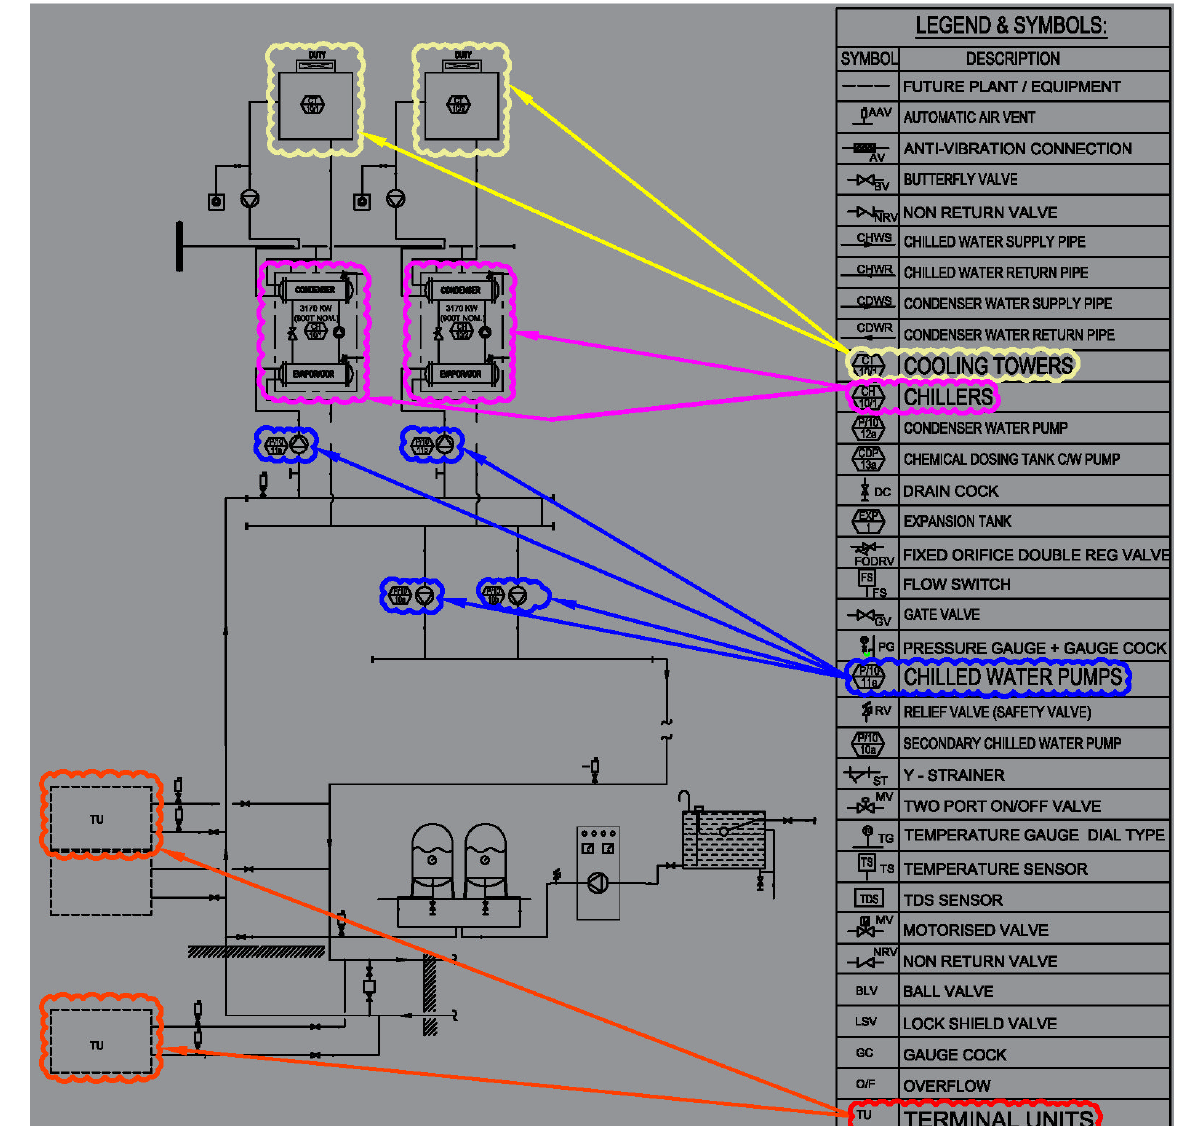
Figure 3. CWS As-Built